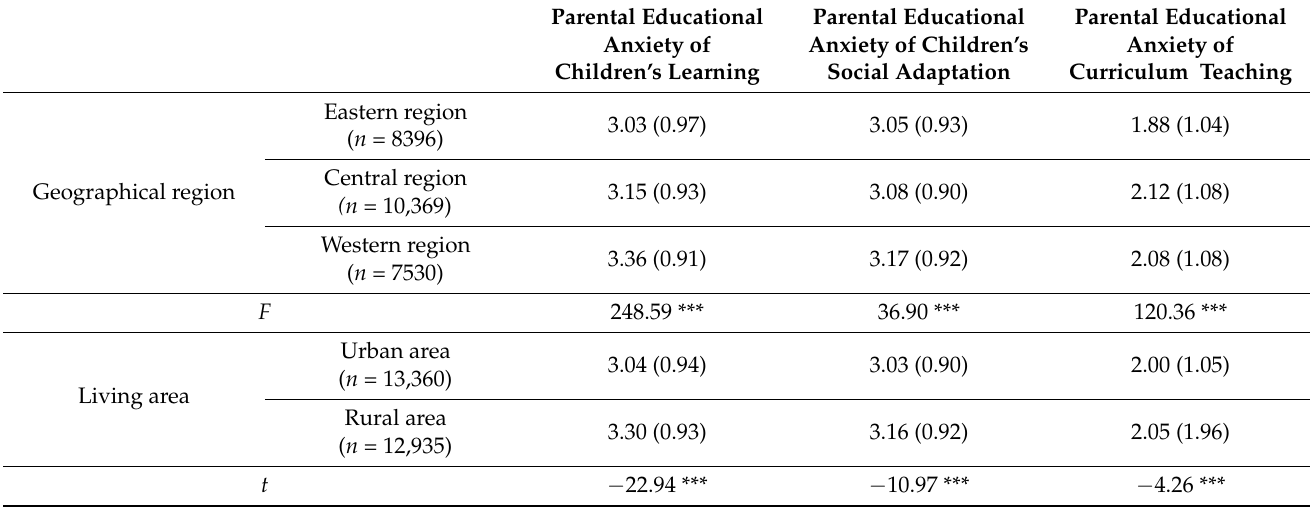
Table 2. Descriptive statistics for parental educational anxiety in relation to different background variables .